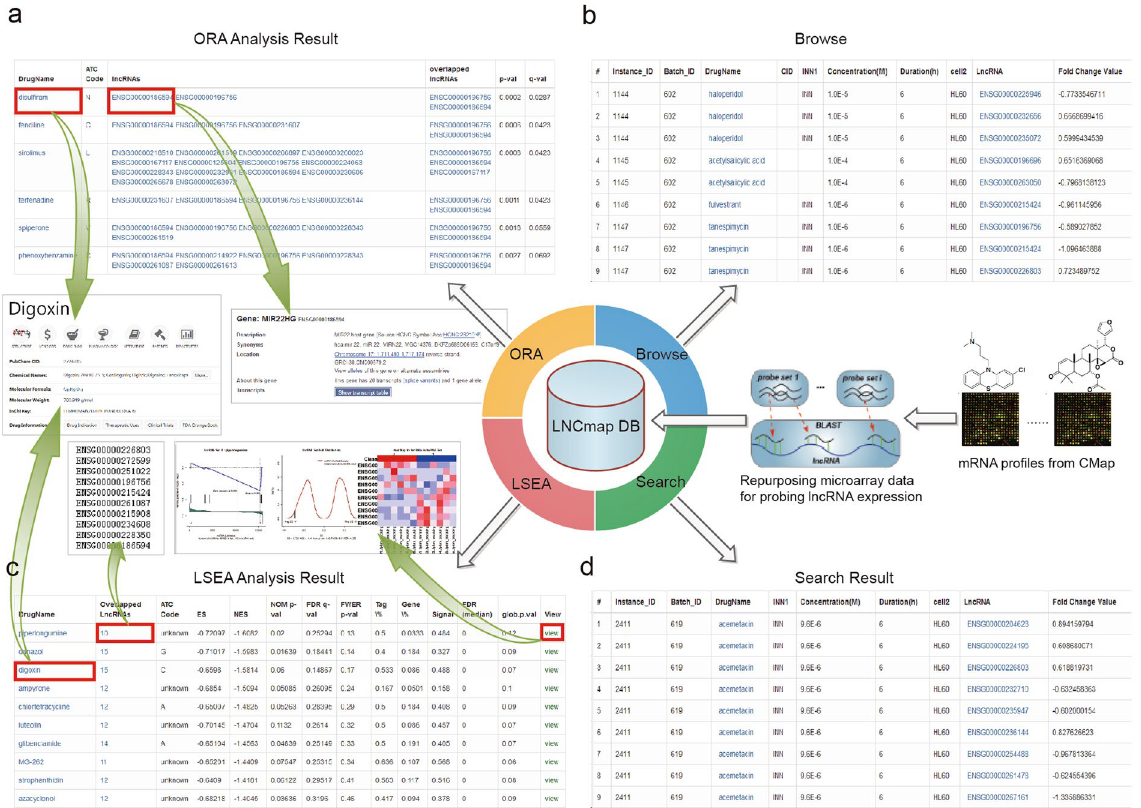
Figure 2. Display of LNCmap website functions. ( a ) The ORA analysis results. ( b ) The browsing of the LNCmap dataset. ( c ) The LSEA analysis results. ( d ) The search results of